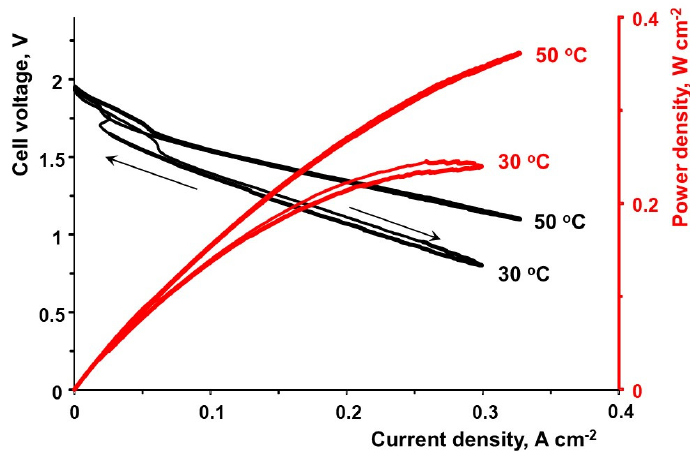
Figure 1. Performance of the Al/NaBrO 3 flow cell at 30 and 50 °C.